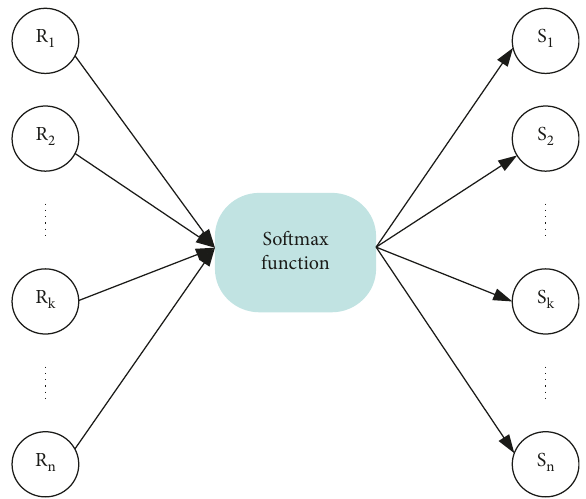
Figure 3: Schematic diagram of Softmax function